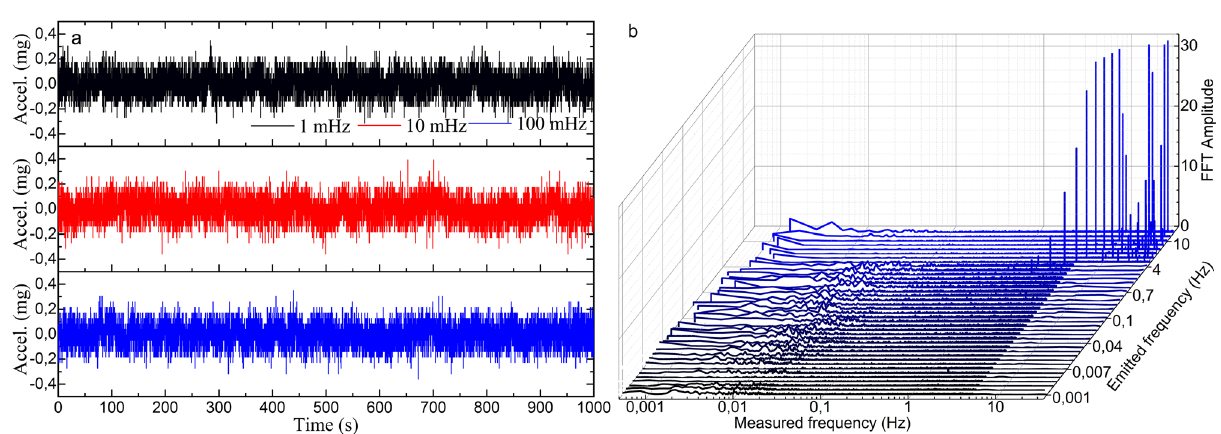
Figure 8. Results of the acceleration measurements in the electronic accelerometer. ( a ) Time response of three representative cases. ( b ) FFT amplitudes for frequencies from 30 Hz down to 1 mHz for a sinusoidal signal of 1 Vpp. The Measured frequency axis is in logarithmic